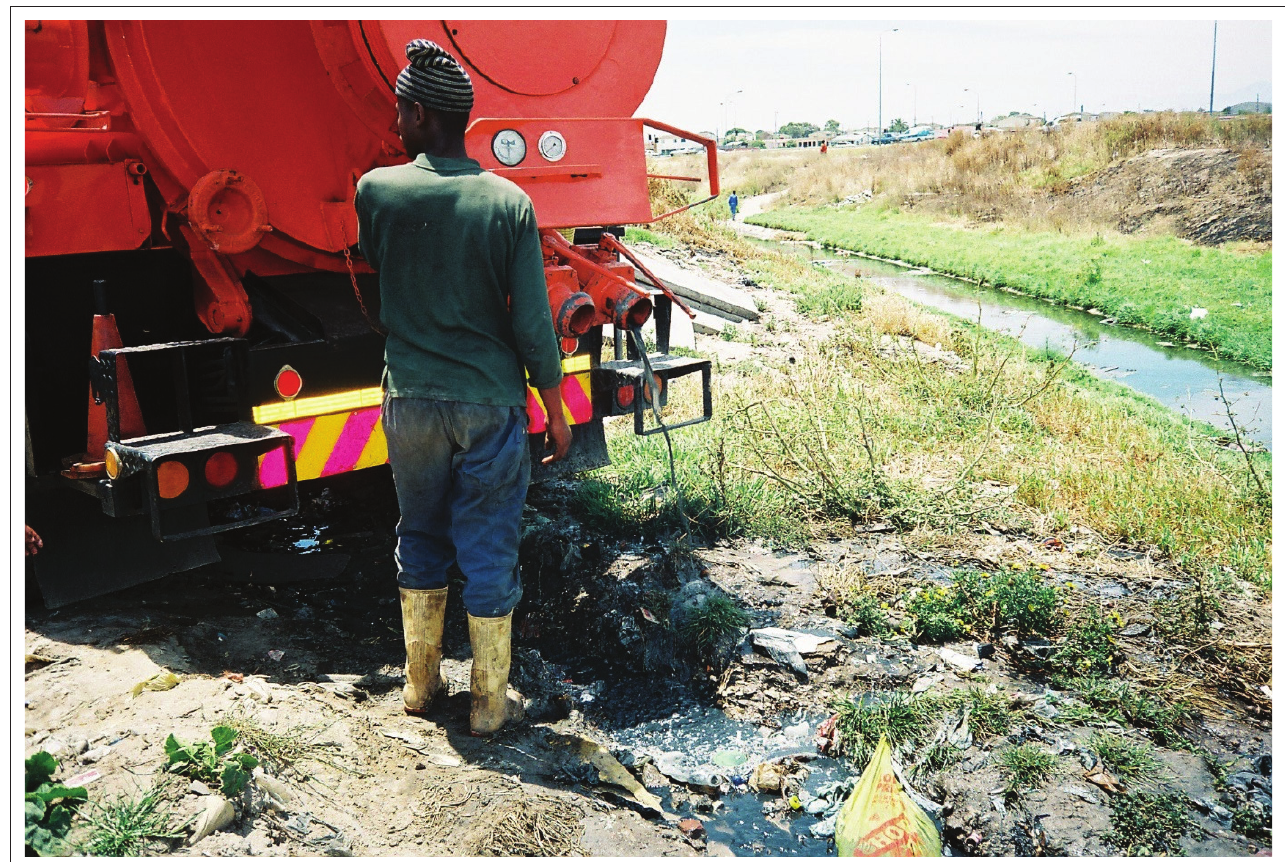
FIGURE 4: Discharge of industrial waste into a storm water canal – in broad